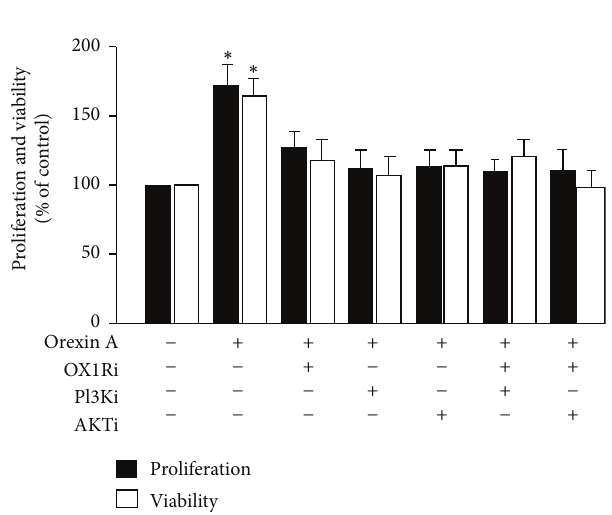
Figure 5: Effects of OXA on the proliferation and viability of INS- 1 cells via stimulation of the AKT signaling pathway. Cells were exposed to OXA at concentrations of 0M and 10 −8 M for 24 h in the presence or absence of PF-04691502 (AKTi) (10 −6 M), wortmannin (PI3Ki) (10 −8 M), SB334867 (OX1Ri) (10 −6 M), or a combination of these antagonists. In addition, cells were incubated with AKTi, PI3Ki, OX1Ri without OXA treatment for 24 h. Proliferation and viability were determined by BrdU assay and MTT test. Data are presented as mean ± SEM based on triplicate determinations from a representative experiment. Asterisks indicate significant differences when compared to controls ( ∗ 𝑃 < 0.05) .